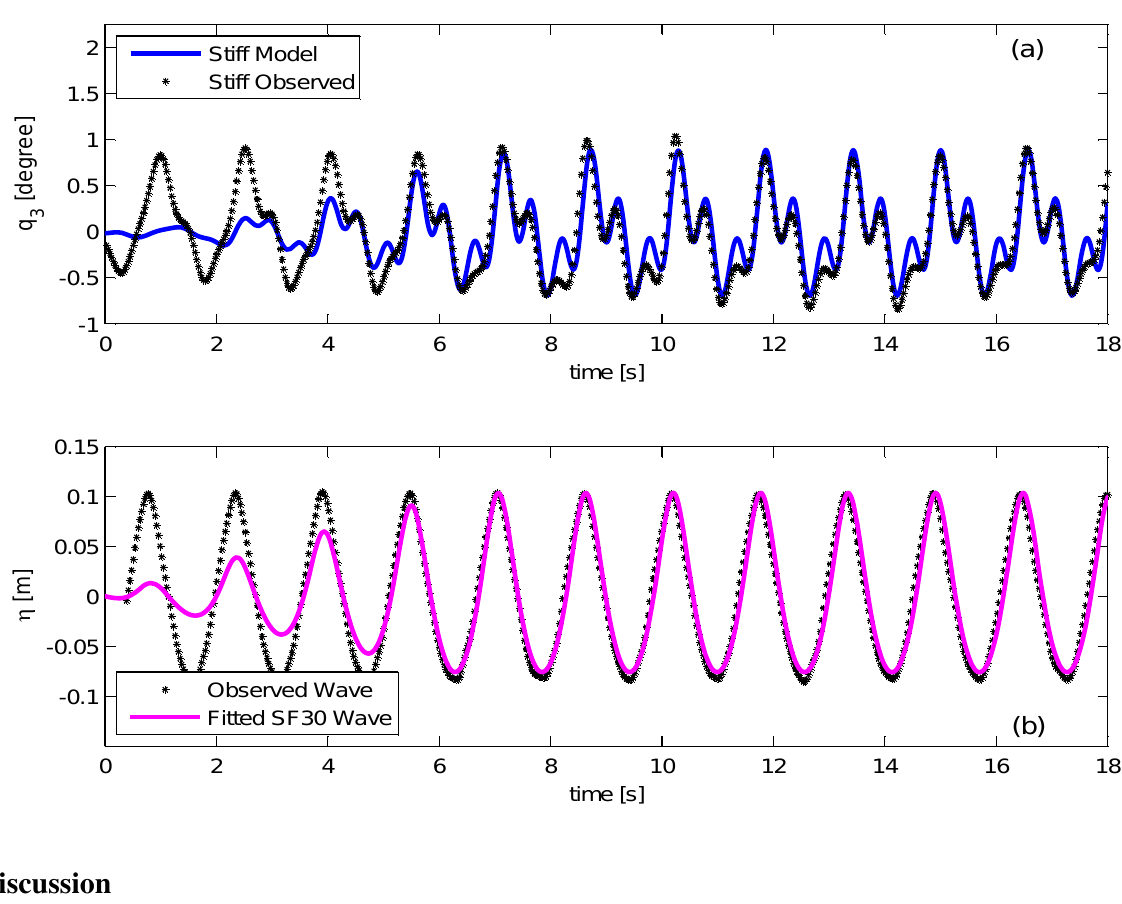
Figure 11. Code-to-experiment comparison between the stiff hybrid model and experimental data under regular wave load conditions. ( a ) Pitch motion comparison; ( b ) Surface elevation